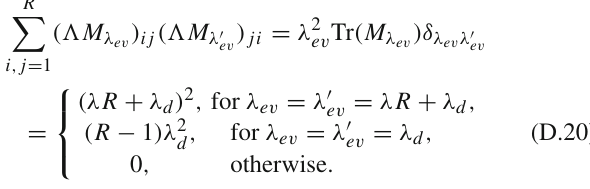
Fig. 10 An example of Wick contraction of P i puted by inserting the matrices A and B at the locations of